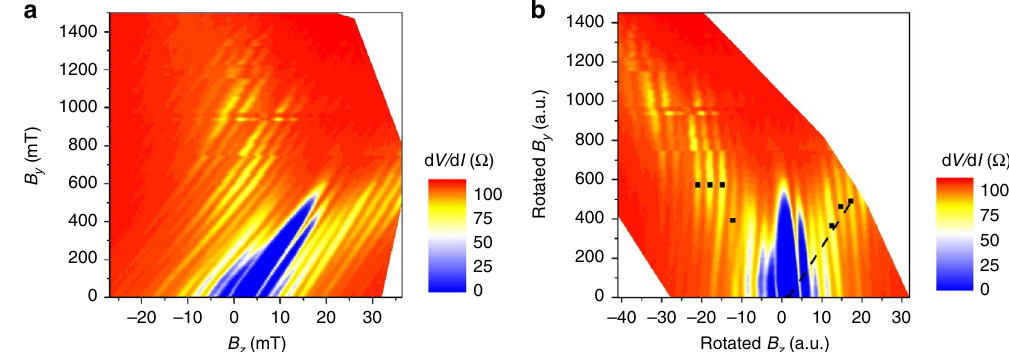
Fig. 2 Device 1 Fraunhofer evolution. a Evolution of the Fraunhofer patterns for device 1. b Fraunhofer evolution for device 1 that has been rotated so that the lobe minima are vertical, making it easier to compare across samples. There is a side branch feature that develops as B y is applied to the junction, which can be quanti fi ed as a line with slope m (dashed line). Black dots mark approximate locations of minimum resistance at different side lobes as a guide to the